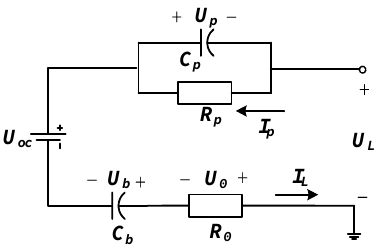
Figure 2. PNGVs battery equivalent electric circuit. C b , open-voltage fluctuation; C p , polarization capacitance; I L , current; R 0 , ohm resistance; R p , polarization resistance; U b , fluctuation voltage of open-voltage; U L , voltage of the battery; U oc , ideal voltage source; U p , over-voltage; U 0 , ohm resistance voltage.